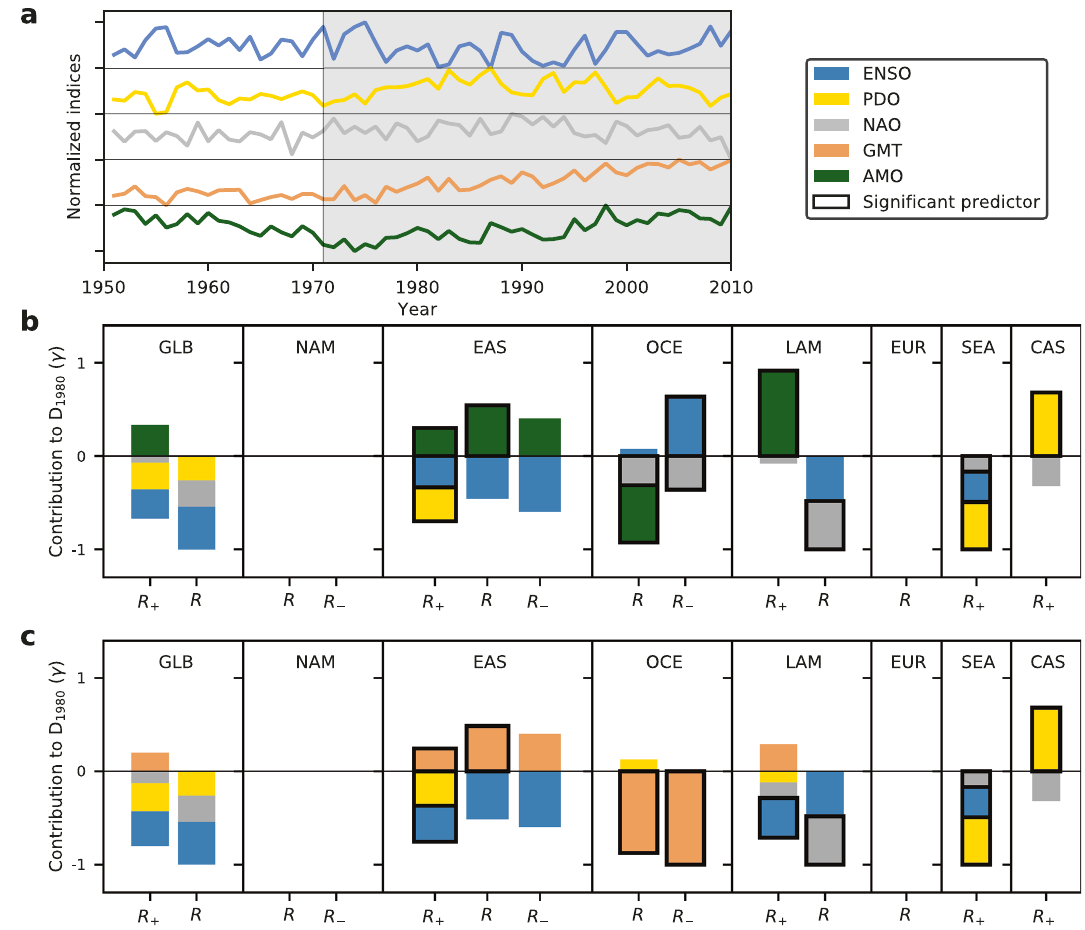
Fig. 5 Predictors of climate-induced trends in fl ood damages. a Normalized indices of ENSO, PDO, NAO, AMO, and GMT from 1971 to 2010. Only the period 1971 – 2010 is used for the analysis (gray shading). b Relative contribution ( γ ) of each climate-oscillation indicator in the best GLM to the damage time series D 1980 accounting for climate-induced trends and variability only ( fi xed 1980 exposure and vulnerability) (cf. Methods). Black boxes indicate signi fi cant predictors at 10% level. Shown are only regions with R 2 > 20% for the full model. c Same as b , but using ENSO, PDO, NAO, and GMT as